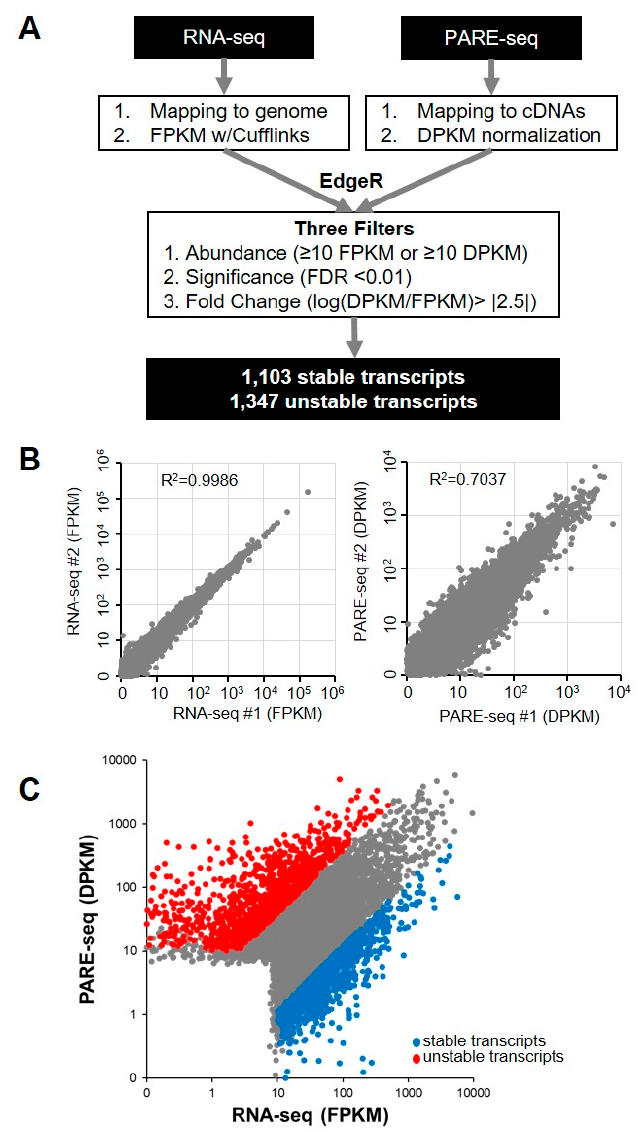
Figure 1. Identification of stable and unstable transcripts. ( A ) Pipeline for the identification of stable and unstable transcripts from RNA-seq and Parallel analysis of RNA ends (PARE)-seq libraries. All sequences from RNA-seq and PARE-seq data were mapped to annotated cDNA and normalized. Stable and unstable transcripts were identified by EdgeR analysis and three filters; ( B ) scatter plots showing the reproducibility of the RNA-seq and PARE seq libraries. Each dot indicates transcripts with abundance values representative of two biological replicate libraries; and, ( C ) scatter plot of transcripts with RNA-seq abundance and PARE-seq abundance values. Blue and red dots indicate stable and unstable transcripts,